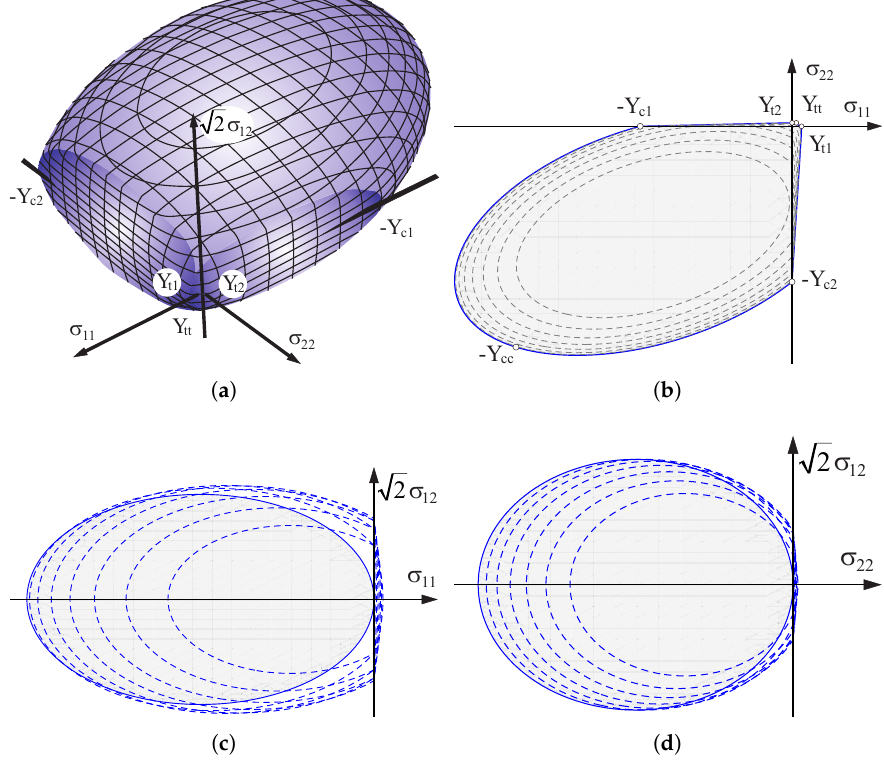
Figure 2. Criterion in orthotropy axes: ( a ) 3D view, ( b – d ) contours (described in